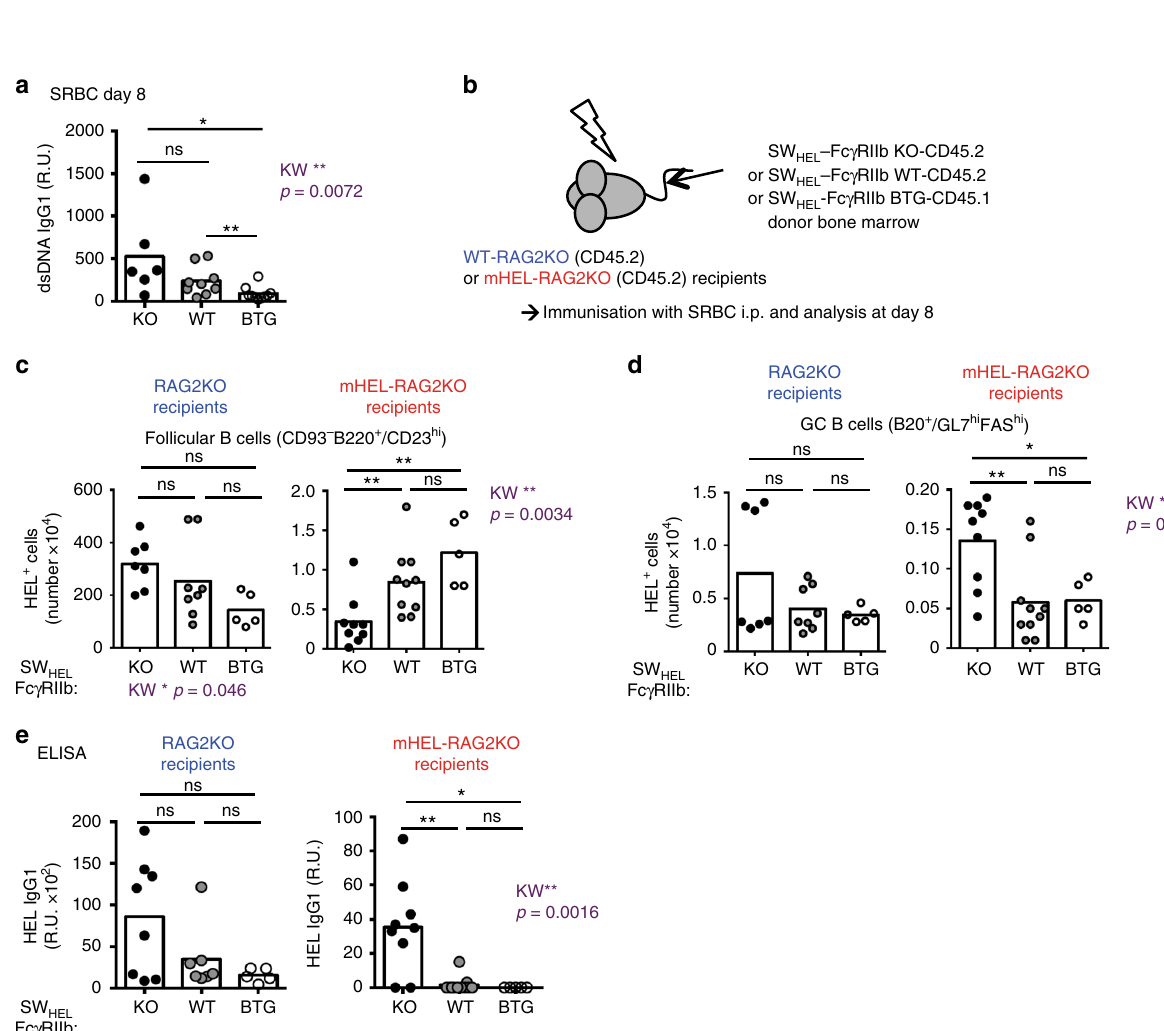
Fig. 5 The impact of Fc γ RIIb on GC tolerance is also observed with a soluble autoantigen. a Wild type and sHEL recipients (both CD45.2) were irradiated and reconstituted with bone marrow from SW HEL -Fc γ RIIb KO-CD45.2, SW HEL -Fc γ RIIb WT-CD45.1 or SW HEL -Fc γ RIIb BTG-CD45.1 donor mice. Post reconstitution, chimera were immunised with SRBC-HEL intraperitoneally and analysed 8 days later. All populations were gated as in Figs. 1, 2 and 4. b – e Quanti fi cation of the frequency of HEL-speci fi c B cells in WT (left panels) and sHEL (right panels) recipient mice: BM immature B cells ( b ), splenic mature MZ B cells ( c ), splenic follicular B cells ( d ) and splenic GC B cells ( e ). f Ratio of HEL-speci fi c GC B cells and total follicular B cells in WT (left panel) and sHEL recipient mice (right panel). g Quanti fi cation by ELISpot of HEL-speci fi c antibody-forming cells (AFCs) in the spleen of immunised WT (left panels) and sHEL (right panels) recipient mice. sHEL recipients: n = 4 – 6 mice per group; wt recipients: n = 2 – 3 mice per group. One experiment representative of at least two is shown. The mean is represented and each dot corresponds to an individual mouse. The p -values were determined with the Kruskal – Wallis (KW) non-parametric test when comparing the three groups (KW: the p -value is indicated in purple for the mHEL recipient. All KW tests were not signi fi cant for WT recipients with the exception of panel e (absolute number) for which KW p -value is indicated for the WT group as well) and with the Mann – Whitney non-parametric test when two conditions were compared (indicated by black stars). * p < 0.05; ** p < 0.01. Comparisons generating non- signi fi cant p -values were indicated with “ ns ” . Source data are provided as a Source Data fi le